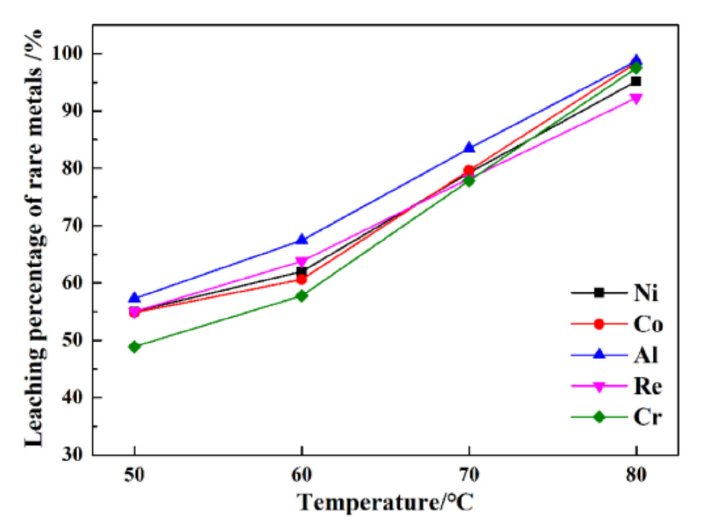
Figure 4. The leaching percentages of rare metals under various